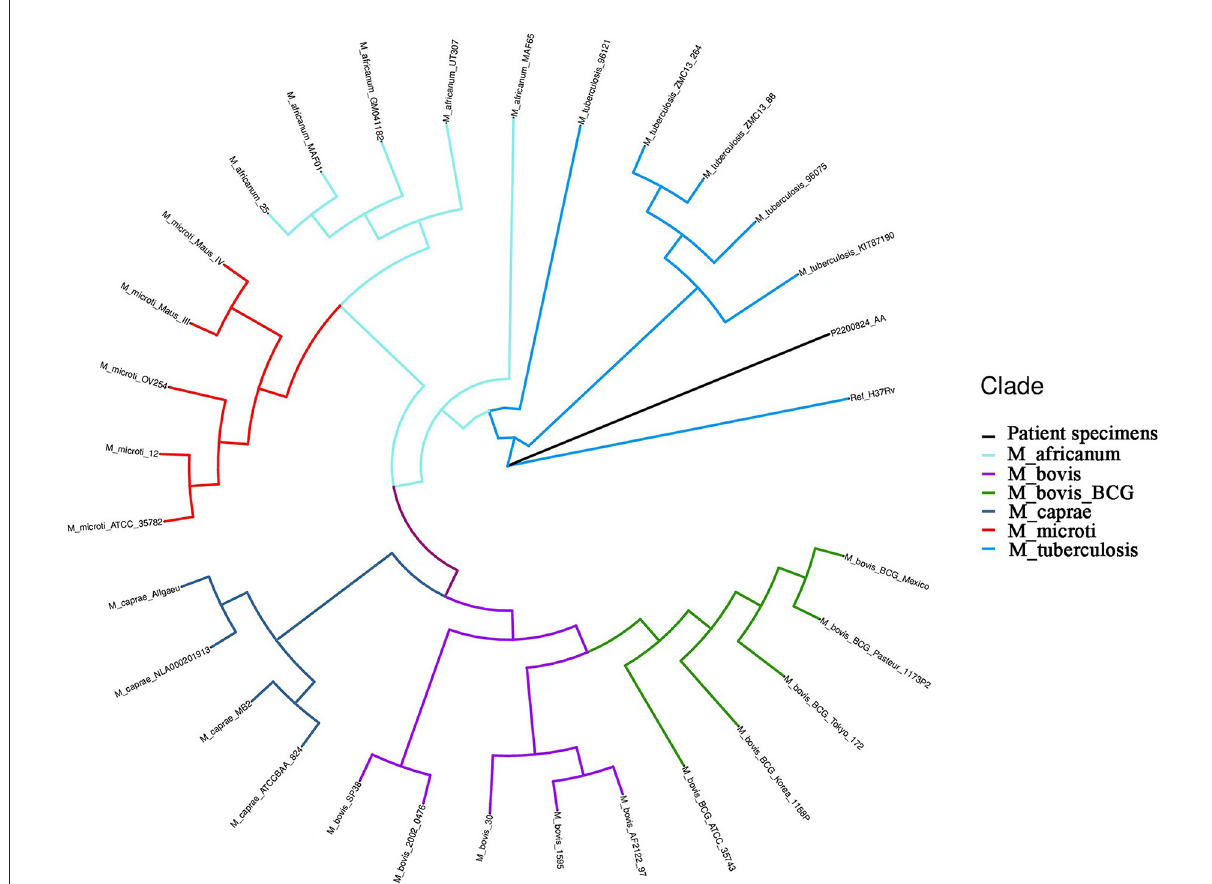
FIGURE2 Hierarchical clustering dendrogram of the growth detection of the serum metagene Mycobacterium tuberculosis complex. Ref_H37Rv: reference of M.tuberculosis H37Rv from NCBI; M_africanum: Mycobacterium africanum ; M_bovis: Mycobacterium bovis ;